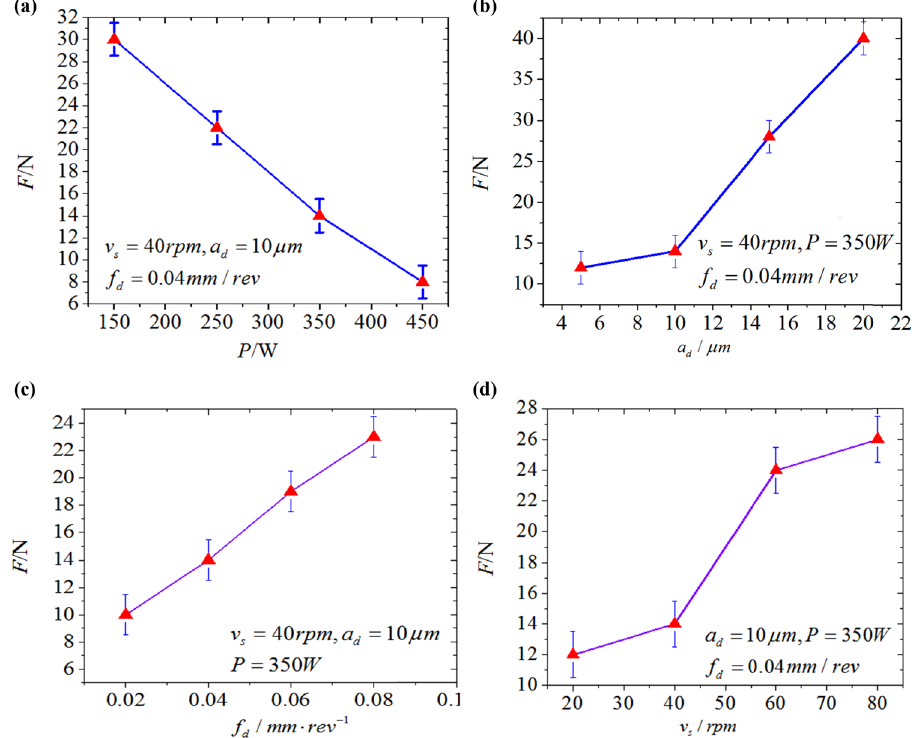
Figure 4: The e ff ect of four dressing process parameters on dressing force F : ( a ) laser power, ( b ) dressing depth, ( c ) feed rate, and ( d ) grinding wheel